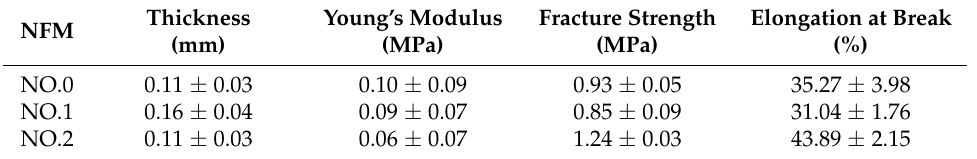
Table 3. Tensile properties of NFMs.